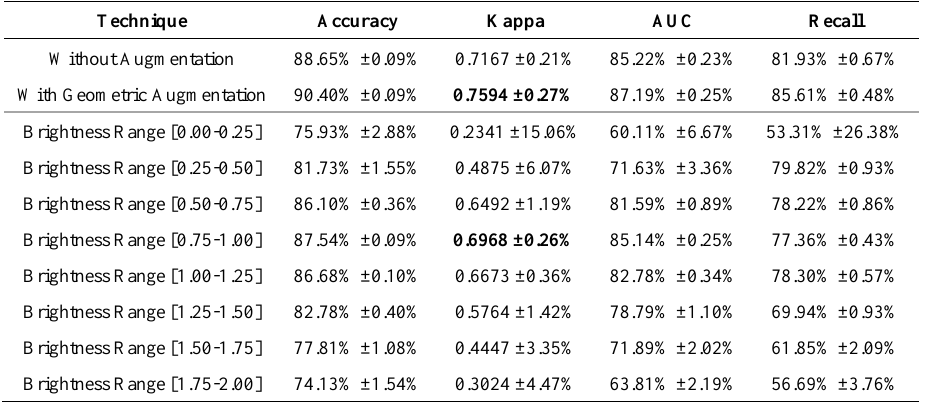
Table 3. Results of InceptionV3 network (± 95% confidence interval over repeated trials)